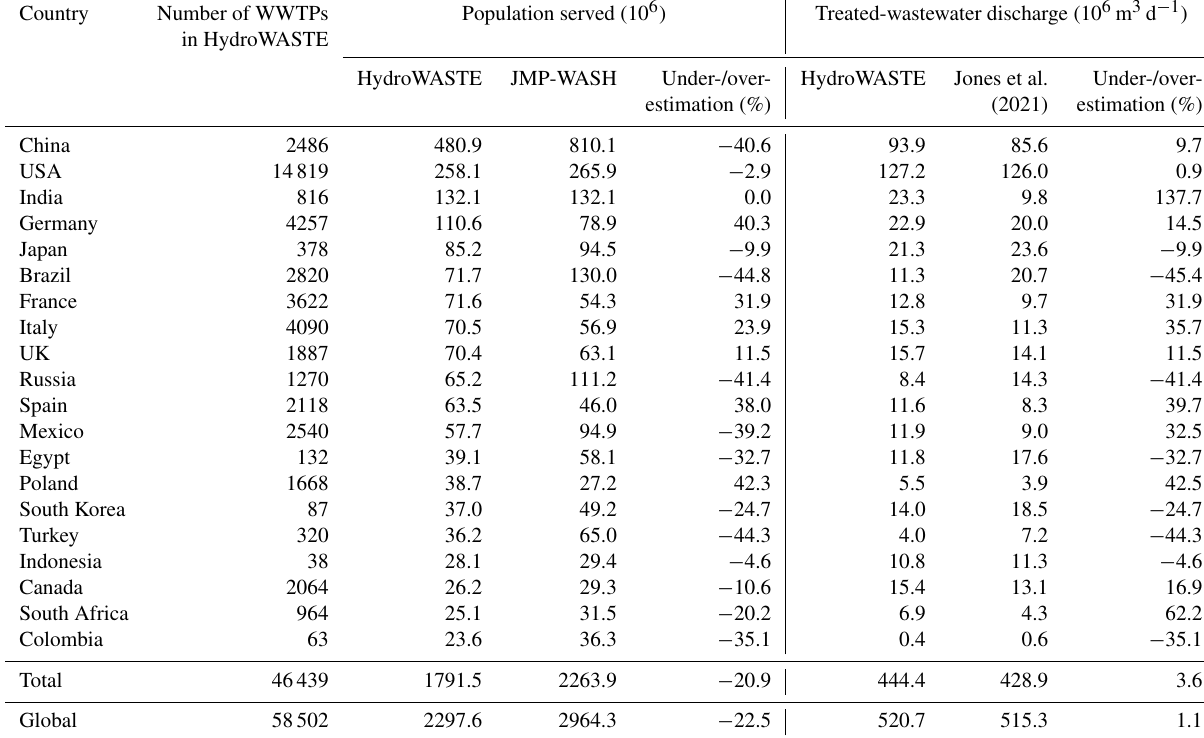
Table 3. Top 20 countries that have the largest numbers of people served by WWTPs according to the HydroWASTE database and their total amount of treated-wastewater discharge. The country-level statistics for population served and treated-wastewater discharge were obtained from the JMP-WASH database (WHO and UNICEF, 2019) and Jones et al. (2021), respectively. Under-/overestimation is calculated using the see Table